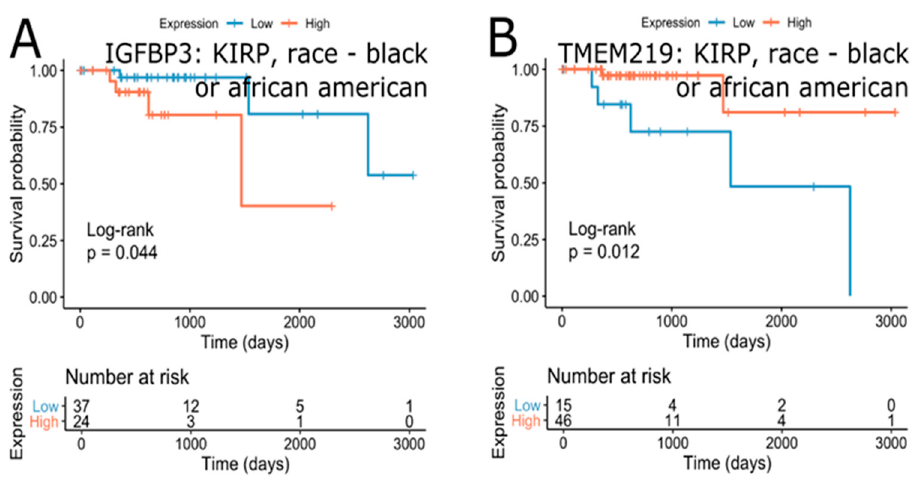
Figure 9. Survival effect of IGFBP3 ( A ) and TMEM219 ( B ) in “race-black or African-American.” Kidney renal papillary cell carcinoma. Unadjusted p-values are shown.